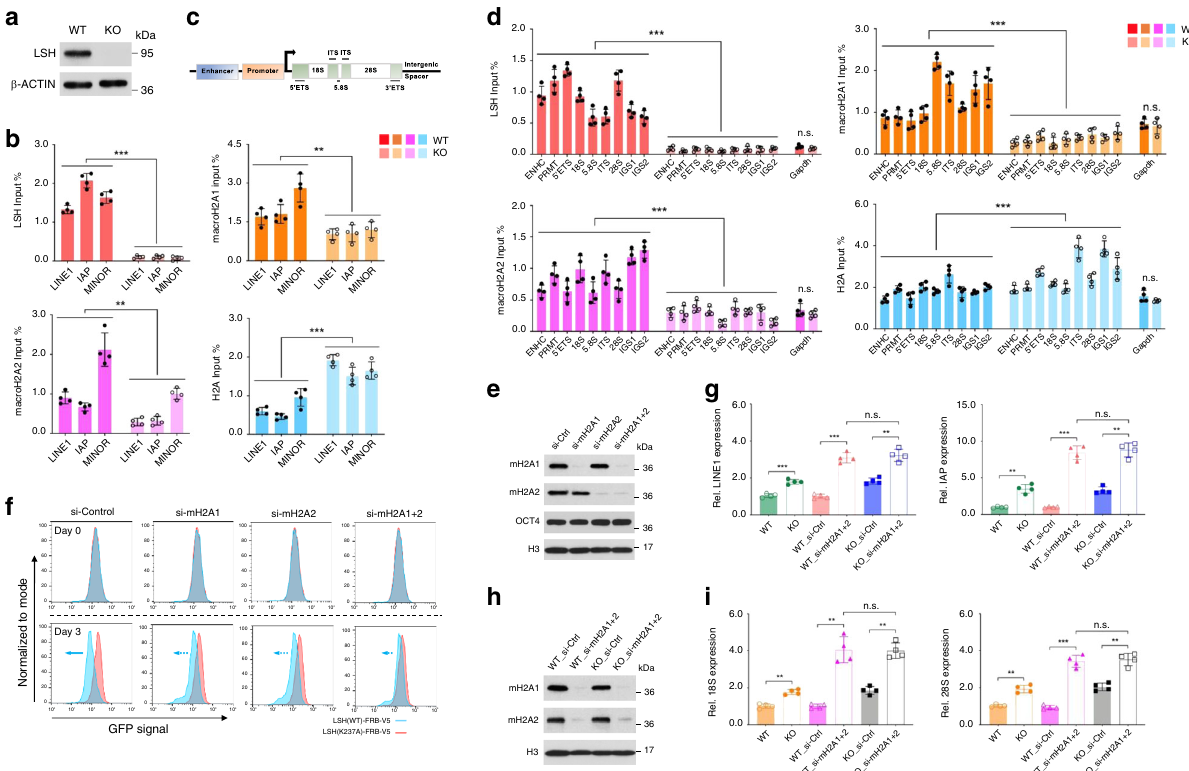
Fig. 3 LSH induced transcriptional repression is in part mediated by macroH2A. a Western blot analysis for detection of LSH protein in Lsh WT and KO MEFs. b ChIP-qPCR analysis for detection of LSH (*** p < 0.0001), macroH2A1 (** p = 0.0002), macroH2A2 (** p = 0.0002), and H2A (*** p < 0.0001) enrichment at repeat sequences, including LINE1, IAP, and MINOR satellites, in KO MEFs compared to WT cells. c , d Schematic representation of mouse rDNA repeats ( c ). ENHC enhancer, PRMT promoter, ETS external transcribed spacer, ITS internal transcribed spacer, IGS intergenic spacer. ChIP-qPCR analysis for detection of LSH, macroH2A1, macroH2A2 and H2A enrichment at rDNA sequences in KO MEFs compared to WT MEFs ( d ). *** p < 0.0001, n.s. means not signi fi cant. e Western blot analysis to detect indicated proteins after single or combined depletion of macroH2A1 and macroH2A2 using